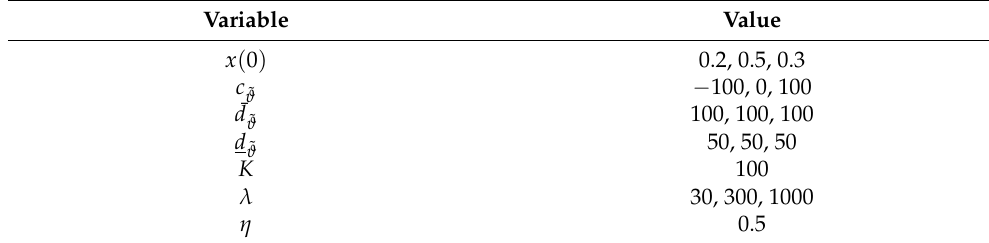
Table 1. Example 1: the simulation parameters.